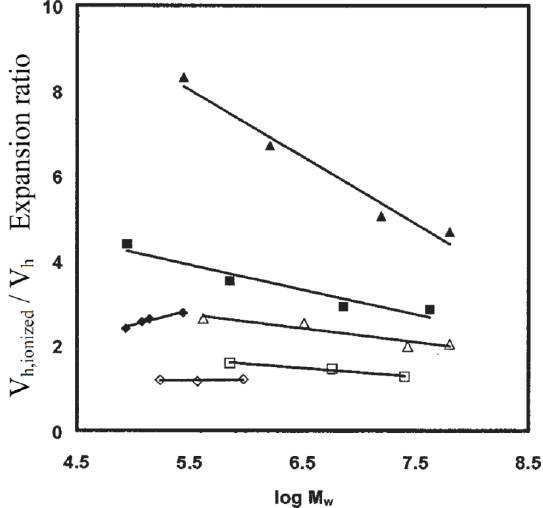
 5,000;  □) and w O 95/5 with 0.10 N HCl. Linear 2  5,000; ■ ) and w